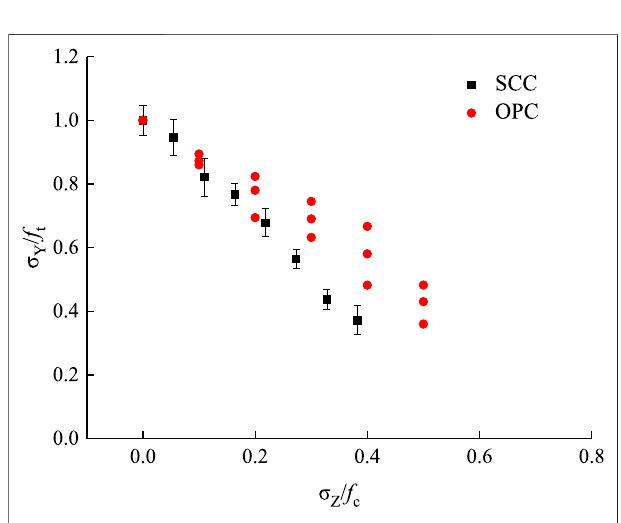
FIGURE 14 | The ratio of principal tensile stress and the ratio of lateral compressive stress of